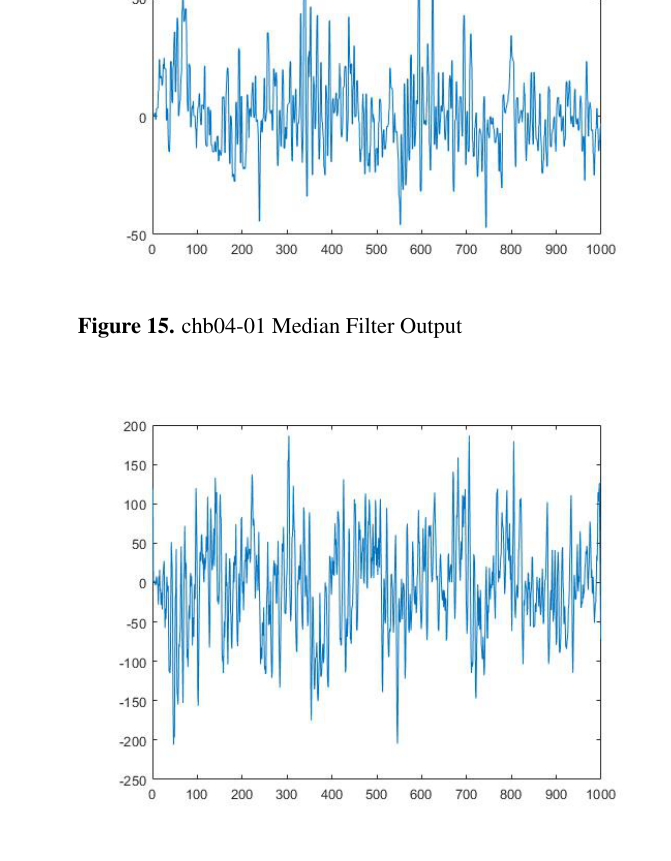
Figure 16. chb05-02 OWA Output